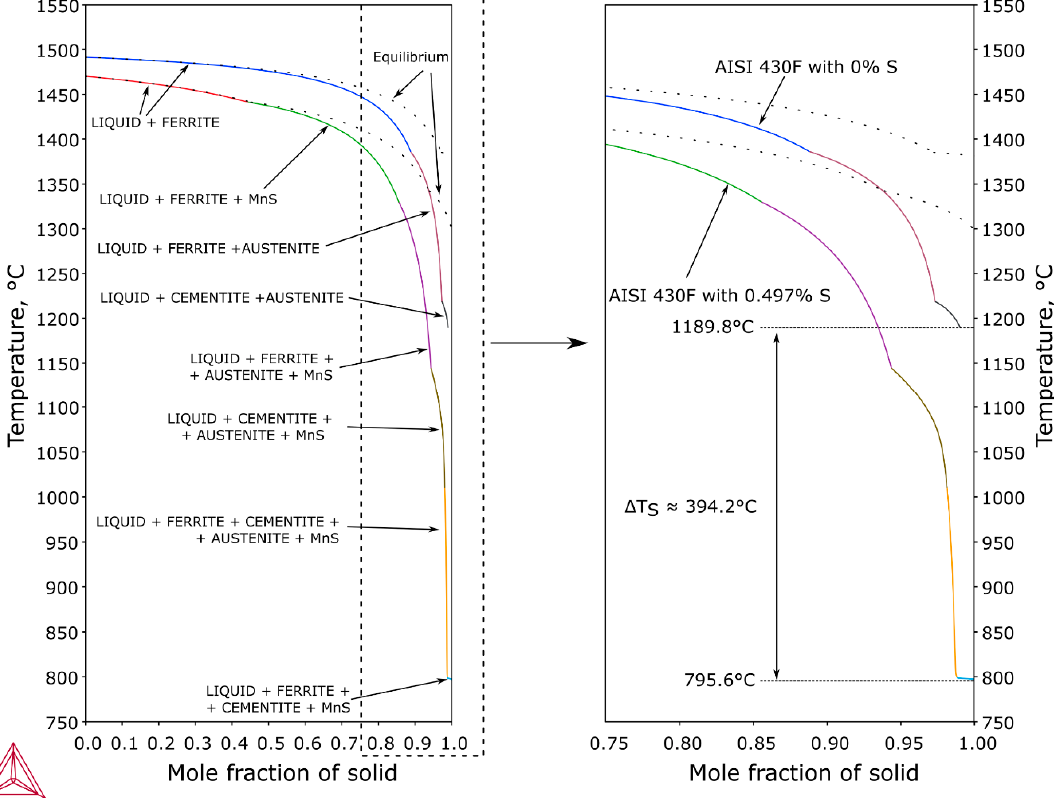
Figure 7. AISI 430F (X12CrMoS17) steel solidification (Scheil Simulation).